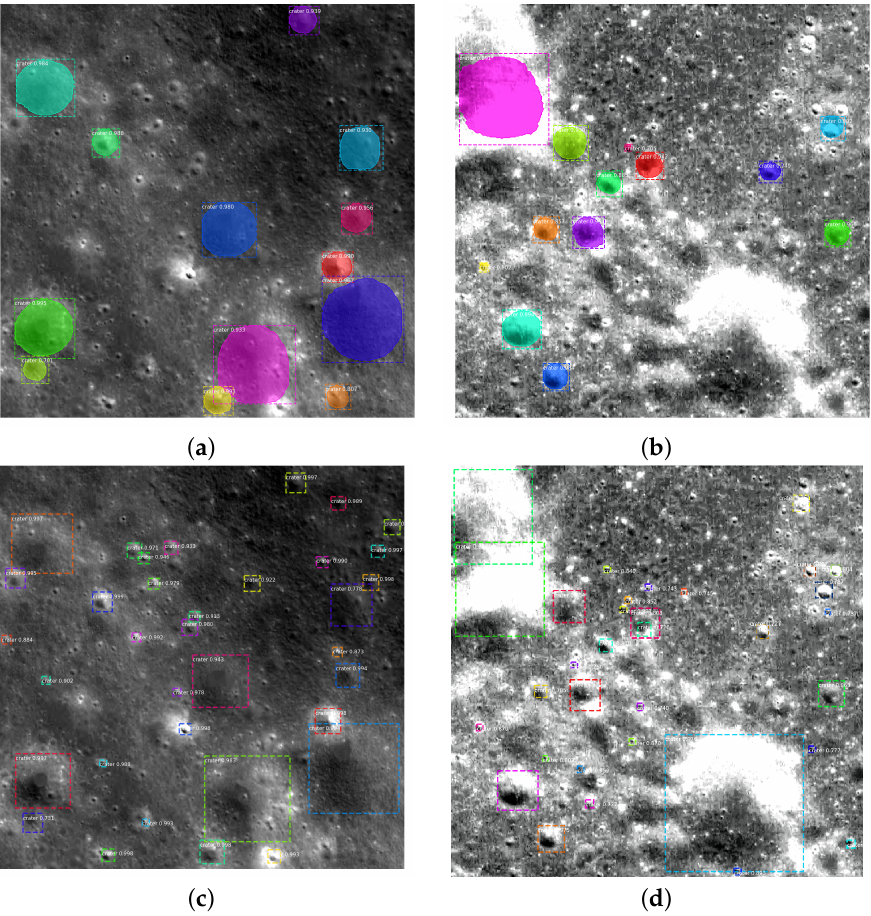
Figure 14. Difference between Mask R-CNN and Crater R-CNN with TTSN: ( a , b ), Mask R-CNN in Highland and Maria; ( c , d ), Crater R-CNN with TTSN in Highland and